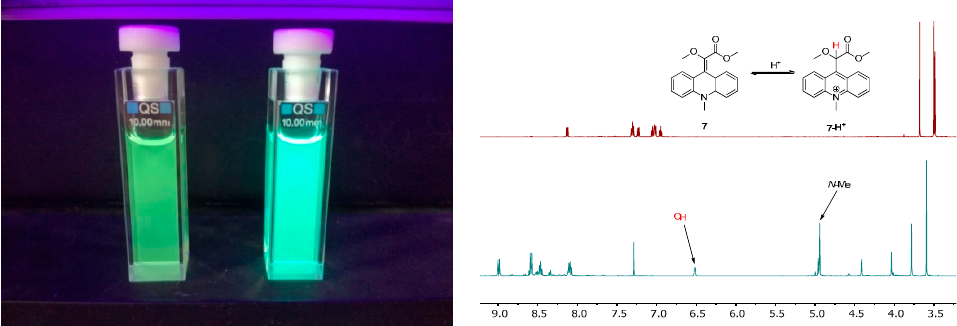
Figure 2. Left: solutions of acridinylidenes ( 7 ) and ( 8 ) (from left to right) in the presence of 500 eq. of TFA in MeCN. The samples were excited with an UV lamp ( λ em = 366 nm); right: acridinylidene (top) 1 H-NMR of ( 7 ) without and (bottom) with 50 eq. of TFA. Two new significant signals at 4.92 ( N -methyl group) and 6.50 ppm (strongly deshielded CH group) appear.